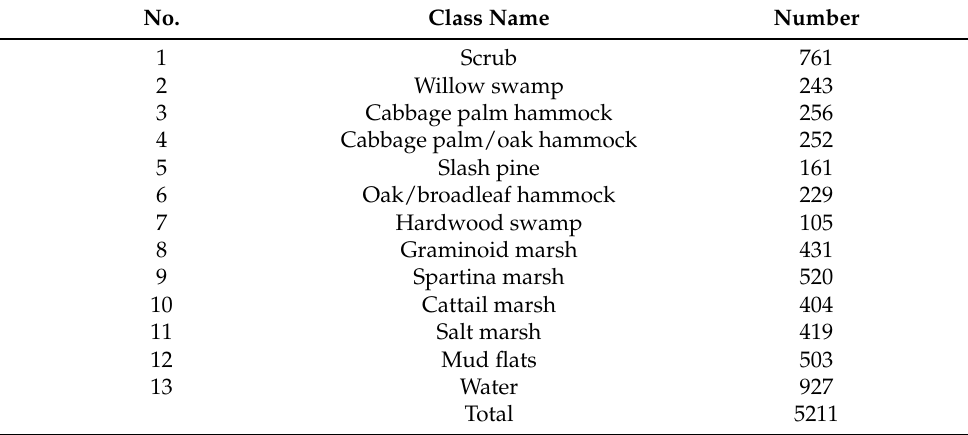
Table 3. Information on the number of samples per category in the KSC dataset.